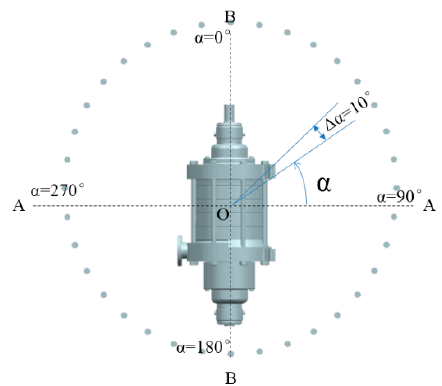
Figure 11. Distribution of external noise monitoring points in the simulations.